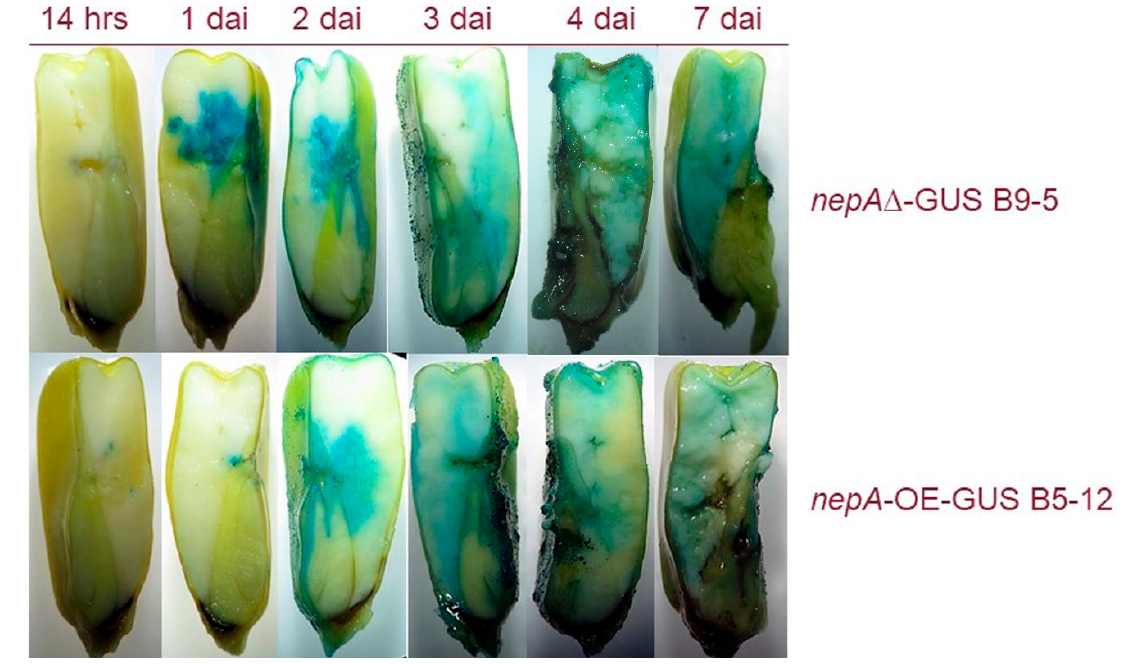
Figure 5. Histochemical assay for nepA ∆ -GUS B9-5 and for nepA-OE-GUS B5-12 strains. Timeline follows infection process starting from the pericarp and the endosperm to the embryo region.